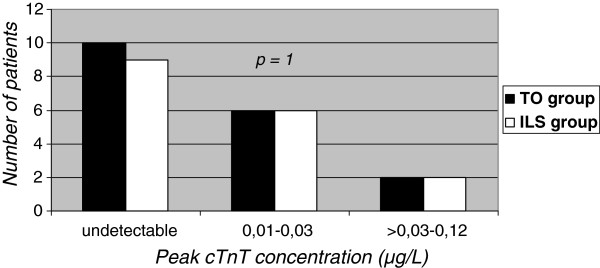
Distribution of peak cardiac troponin T serum concentration postoperatively. cTnT = cardiac troponin T; TO = tournique occlusion; ILS = intraluminal-left anterior descending shunt.